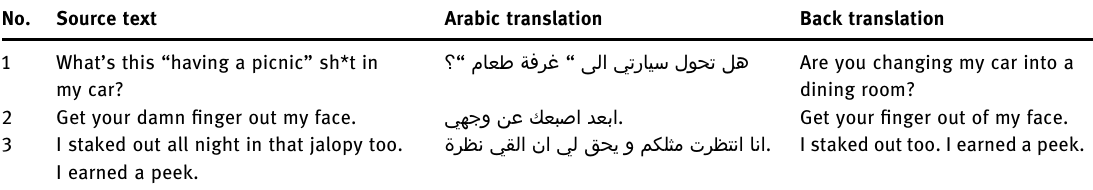
Table 7: Omission strategy